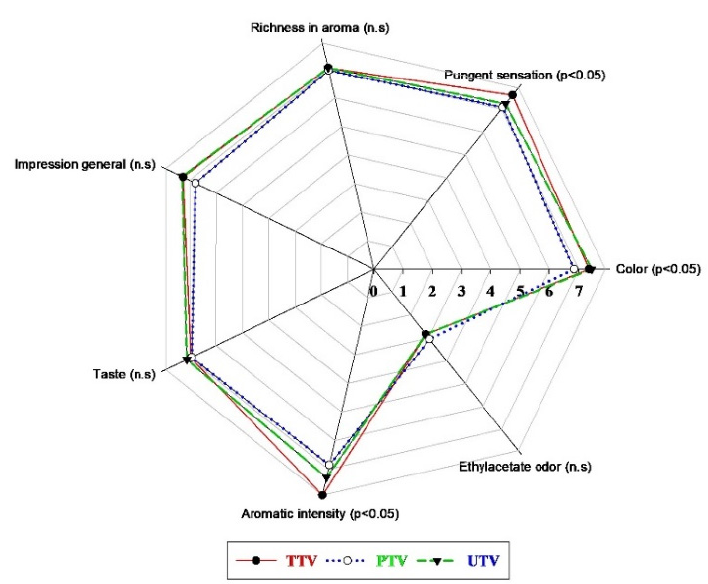
Figure 5. Results of sensory analysis chart for samples. There were statistically significant differences between samples ( p < 0.05). n.s: no statistical difference; PTV: pasteurized tomato vinegar; TTV: traditional tomato vinegar; UTV: ultrasound-treated tomato